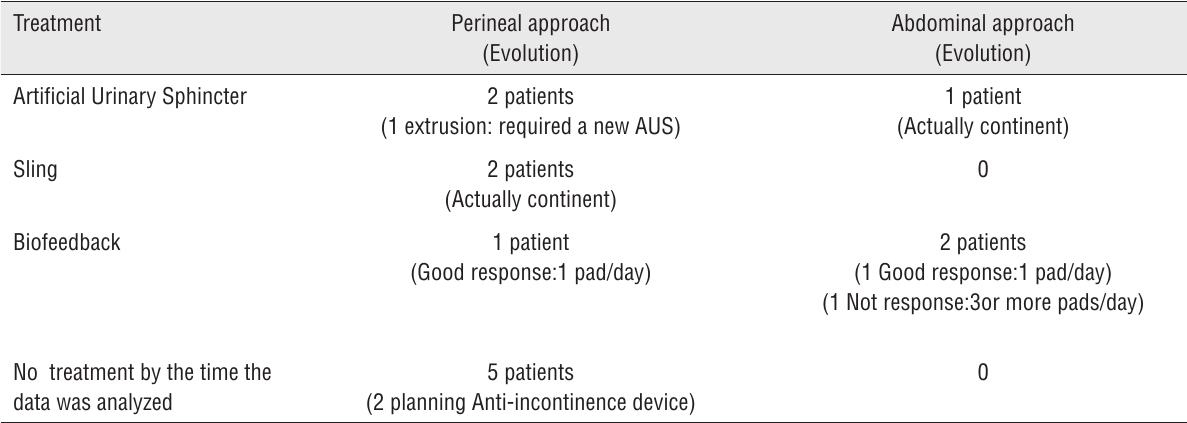
Table 3 - UI treatment and evolution by